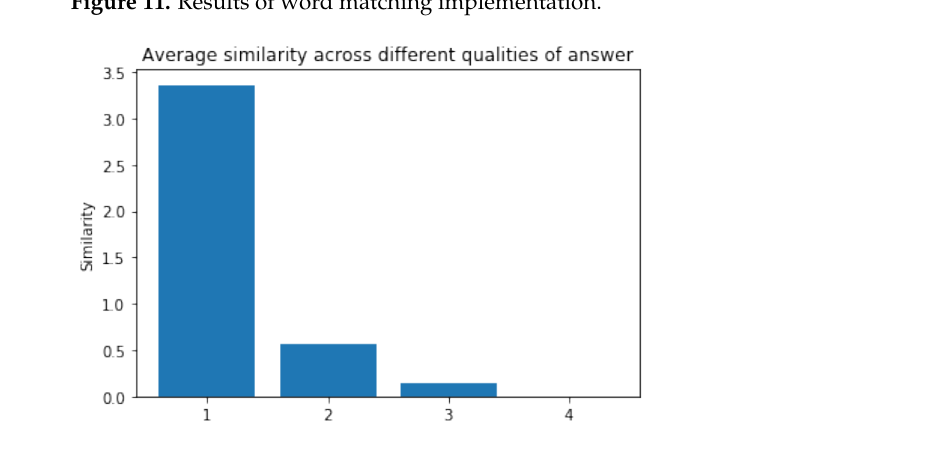
Figure 12. Average word matching